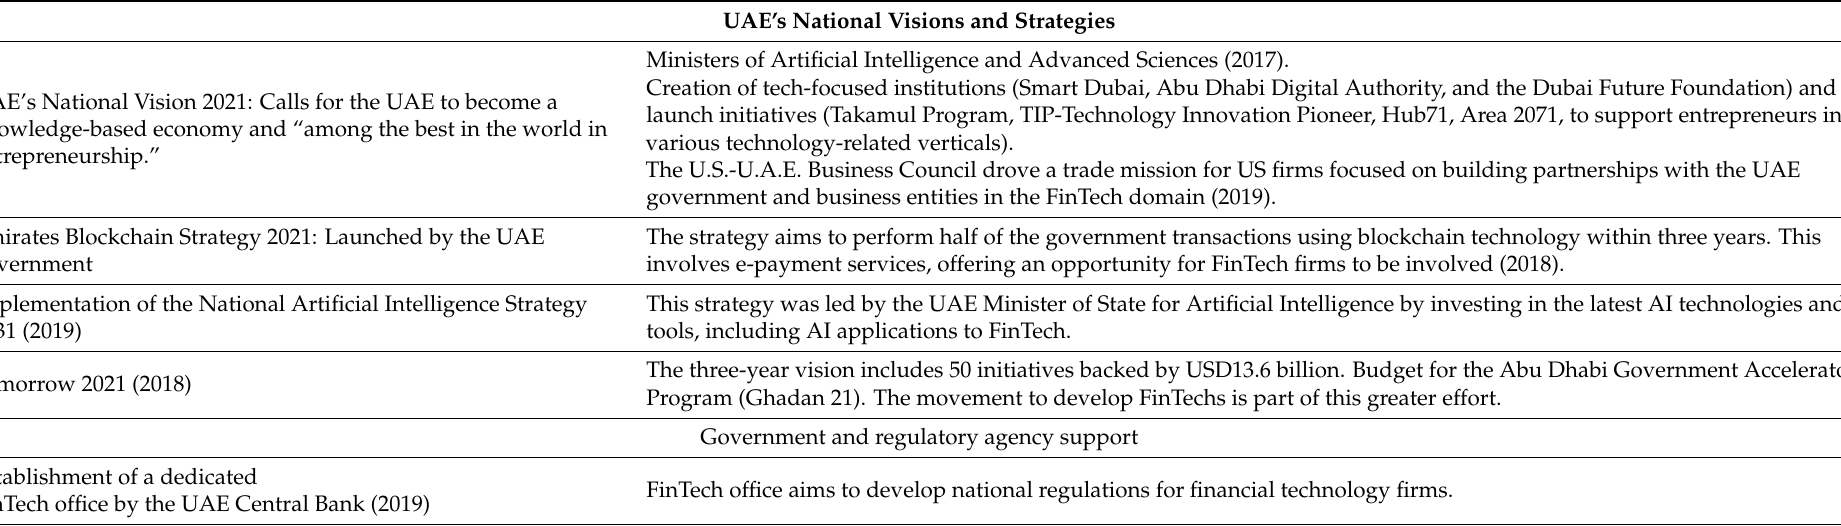
Table A1. The UAE FinTech Ecosystem: An